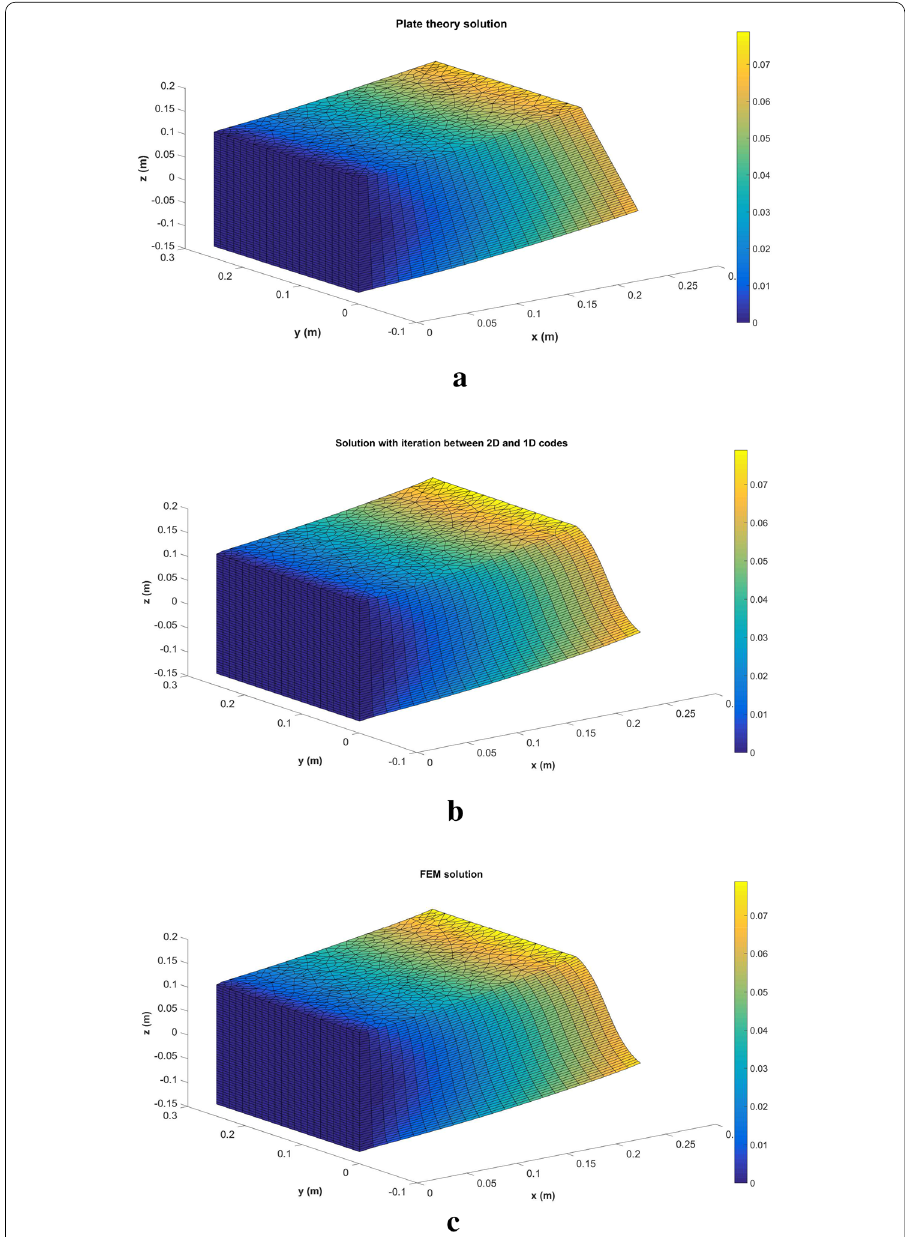
Fig. 2 Displacement field using: plate theory ( a ), minimally-intrusive fully 3D separated plate formulation ( b ), 3D FEM ( c )